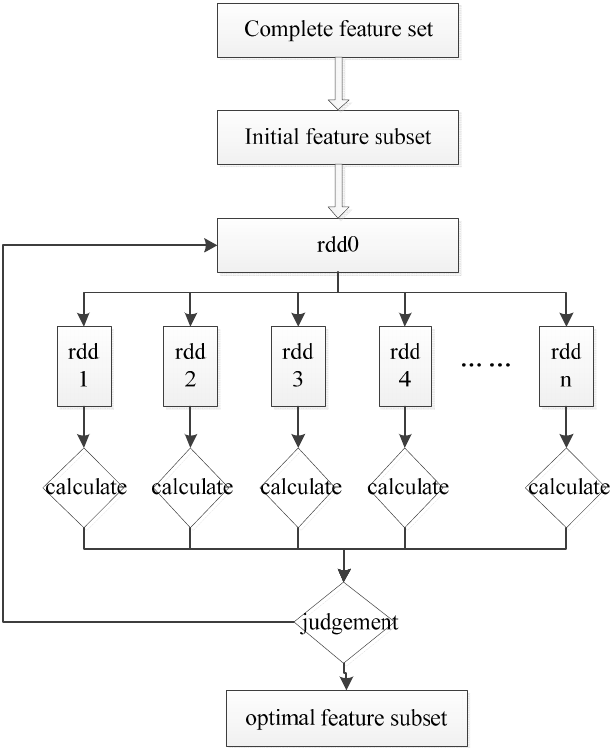
Figure 1. FSMS flowchart.